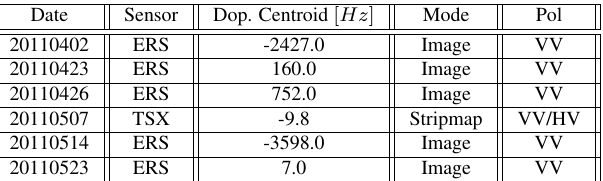
Table 2: Acquired SAR imagery and corresponding characteris- tics